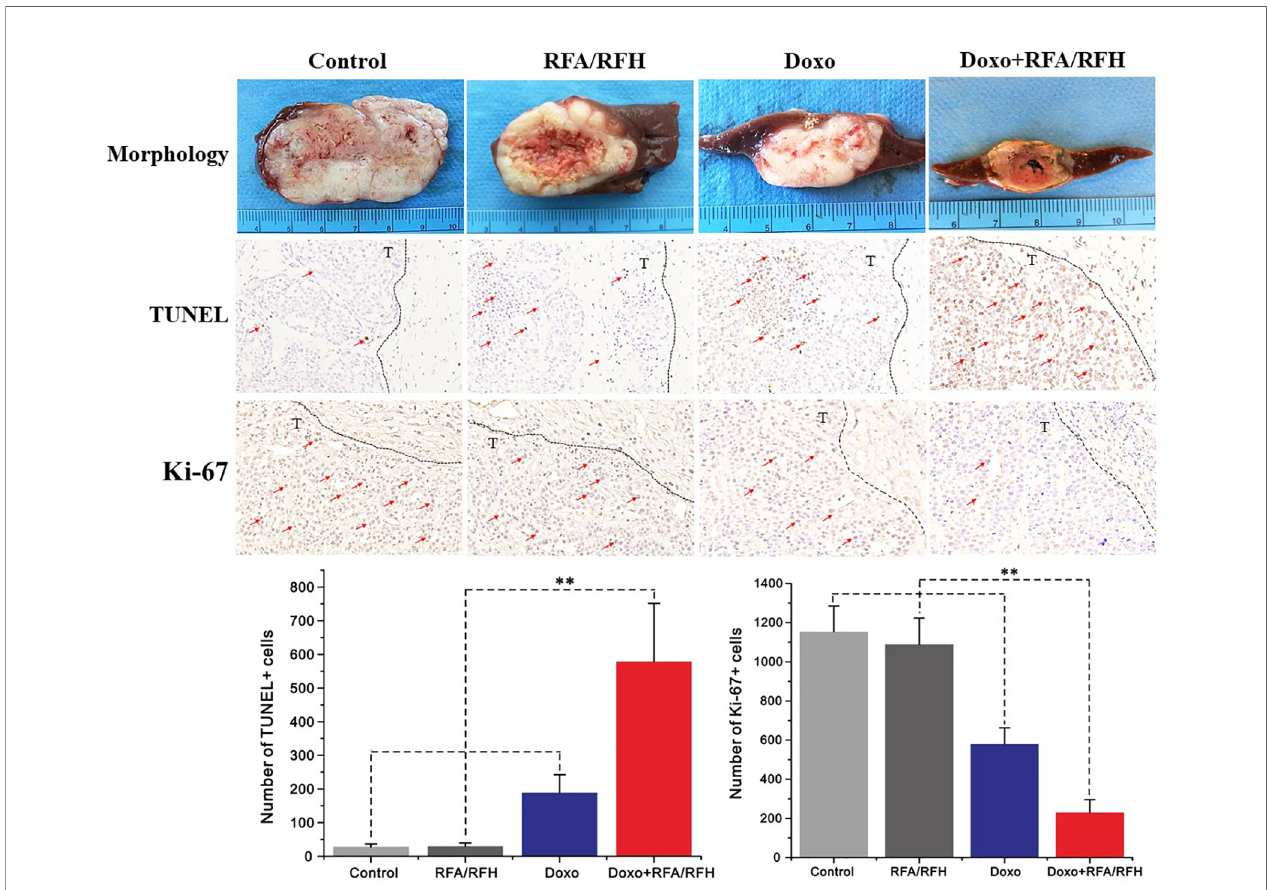
FIGURE 6 | The gross pathology and the corresponding immunohistochemical staining of rabbit orthotopic tumor tissues after the different treatments. The morphology shows the smallest tumor size in the combination therapy group compared to the other three groups. TUNEL staining for apoptosis further con fi rms an signi fi cantly enhanced tumoricidal effect of the combination therapy, and the largest number of brown-stained cells could be detected in the combination treatment, compare to other treatments [Doxo+RFA/RFH (578.67 ± 173.01) vs Doxo (189.33 ± 9.95), RFA/RFH (29.83 ± 9.95), and saline (28.17 ± 8.73); n=6 per group, P<0.01]. Ki-67 staining shows a signi fi cant inhibition of cancer cell proliferation in the combination therapy group, as evidenced by the fewest number of brown- stained cells [Doxo+RFA/RFH (230.17 ± 66.08) vs Doxo (580.33 ± 82.20), RFA/RFH (1089.00 ± 134.50), and saline (1154.00 ± 131.31); n=6 per group, P < 0.01]. **P <